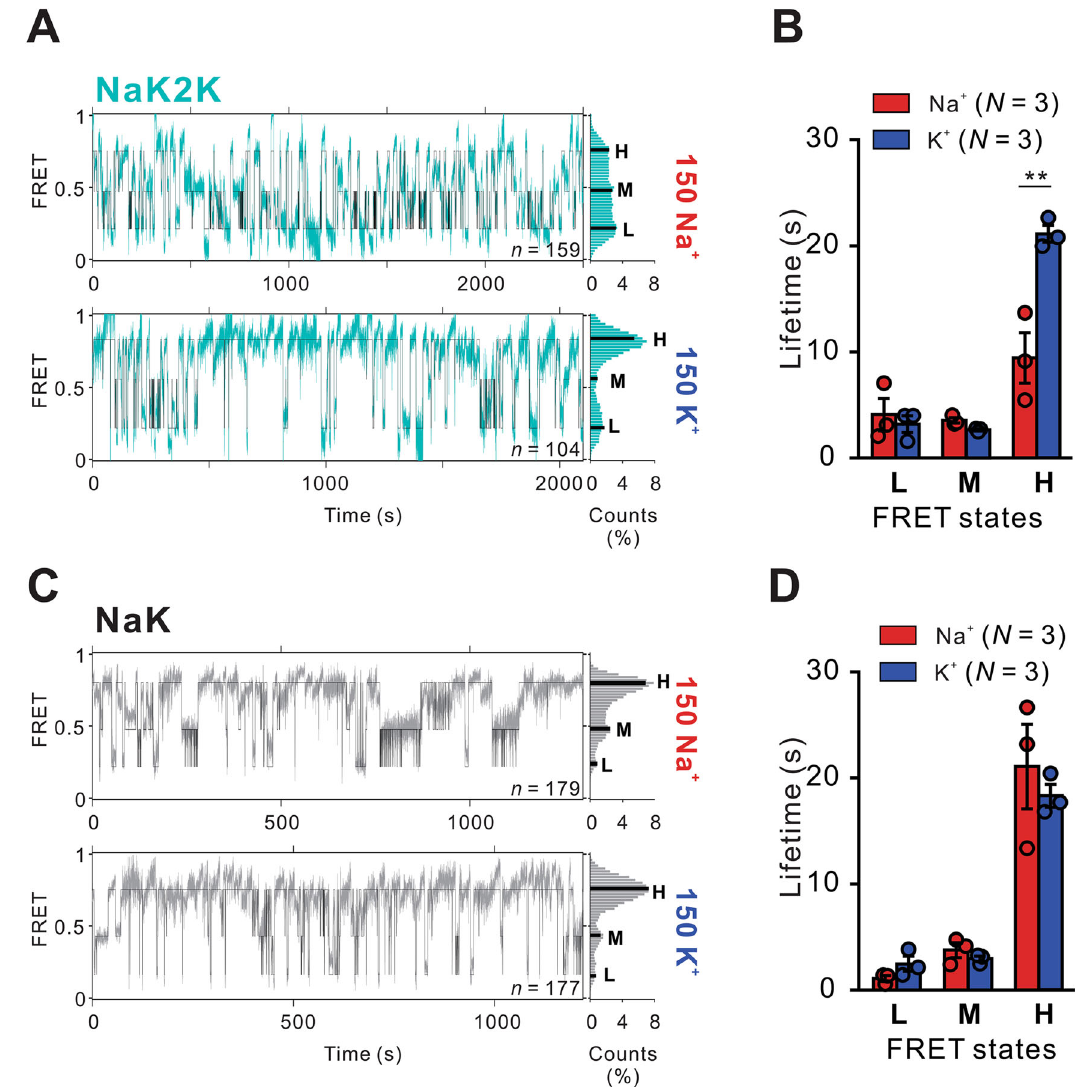
Fig.2|Permeantion-dependentkineticsofNaK2KandNaKSF.A Concatenated (blue) and idealized (black) smFRET trajectories in K + and Na + for NaK2K. Histo- grams of experimental and idealized FRET distributions are shown to the right. B Calculated Lifetimes from the idealized traces shows a decrease in high FRET statesforNaK2KinNa + .K + comparedwithNa + FRETlifetimes(LowFRET p =0.6276; Medium FRET p =0.0640; High FRET p =0.0096). C Concatenated (gray) and idealized (black) smFRET trajectories in K + and Na + for NaK. Histograms of